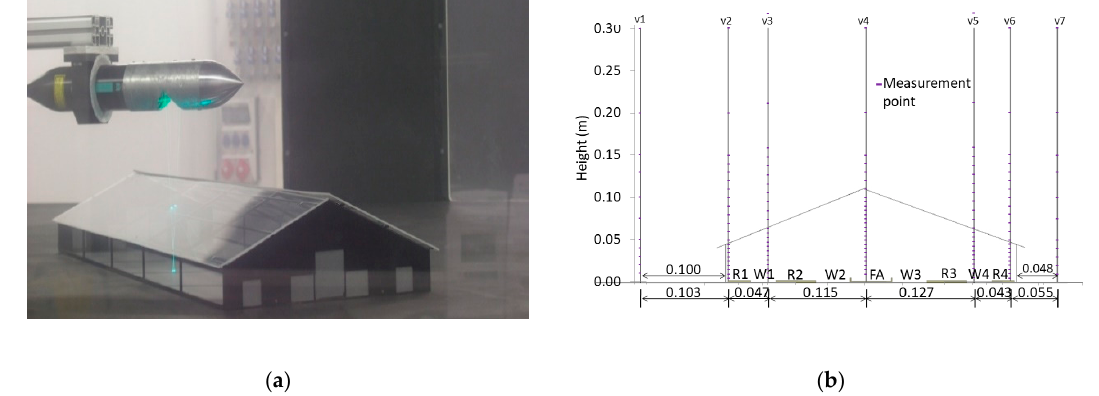
Figure 3. ( a ) A 1: 100 scale model of the NVD building inside BLWT and ( b ) Measurement points in and outside of the NVD barn. R—Cow resting area, W—Cow walking area, and FA—Feeding alley. All dimensions are in m.